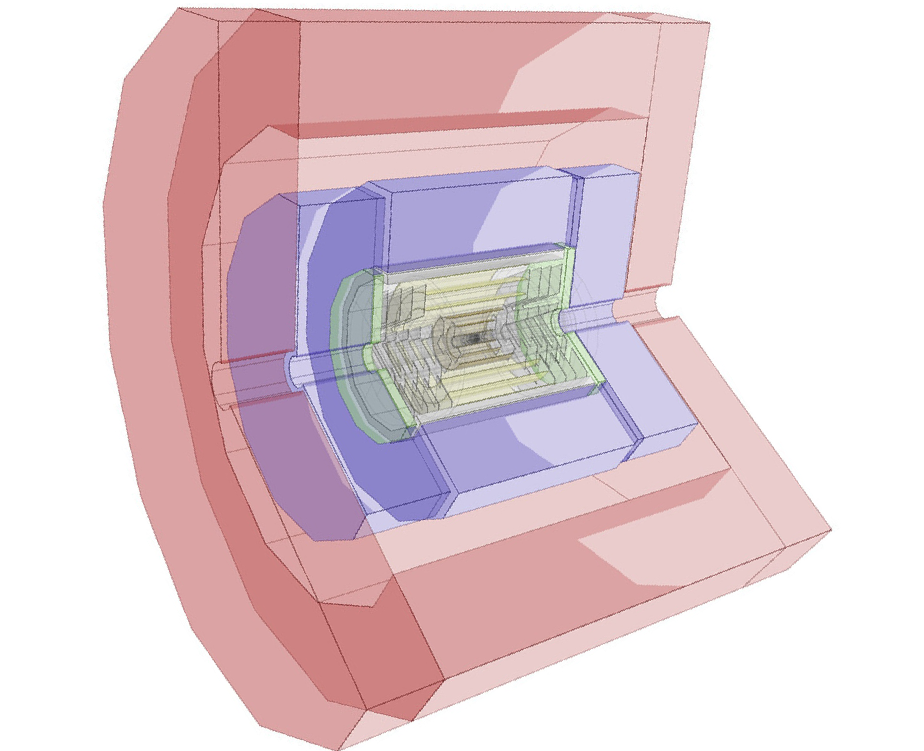
Figure 3. Illustration of the full detector, from the Geant 4 model. Different colours represent different sub-detector systems: the innermost region, highlighted in the yellow shade, represents the tracking detectors. The green and purple elements represent the calorimeter system, while the red outermost shell represents the magnet return yoke instrumented with muon chambers. The space between the calorimeters and the return yoke will be occupied by a 3.57 T solenoid magnet (not